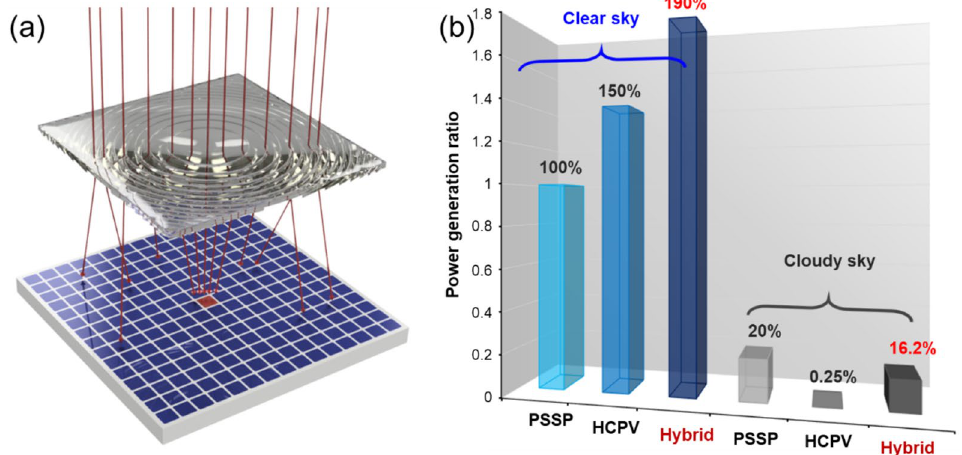
Figure 6. Proposed hybrid high-concentration photovoltaic device. ( a ) The schematic diagram of the proposed hybrid photovoltaic device includes a Fresnel lens, a high-quality III–V photovoltaic component located at the focused area, and conventional PSSP’s arranged around. ( b ) The comparisons of the power generation ratio among the three designs, where blue bars are for clear sky scenario and grey bars are for the heavy-cloud sky scenario referred to Fig.